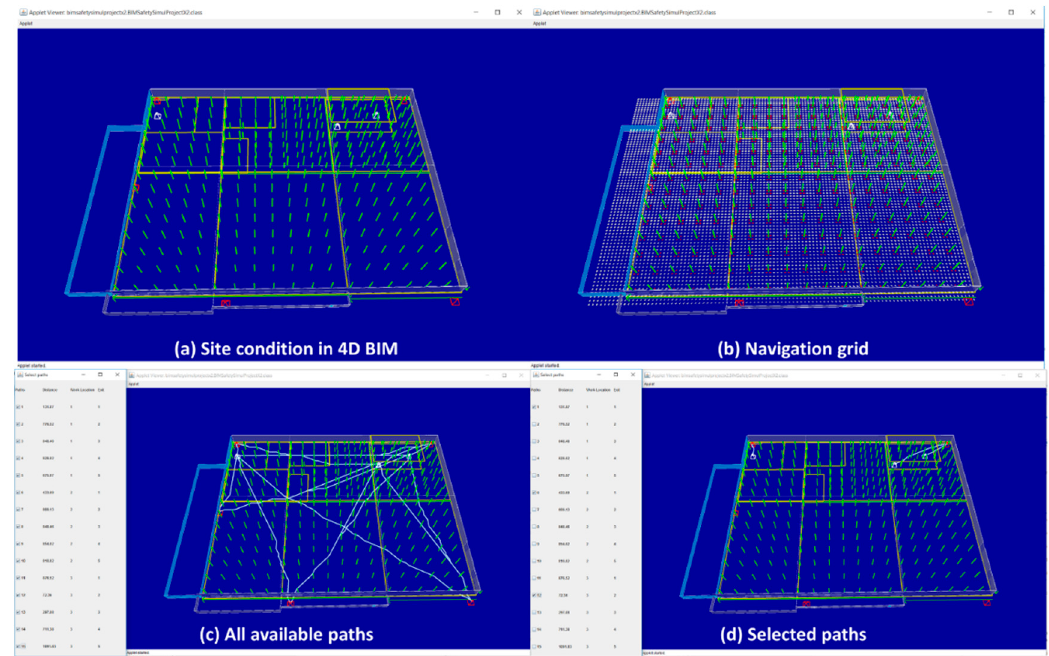
Figure 17. Scenario 3 ( a ) site condition, ( b ) navigation grid, ( c ) all available paths, and ( d ) selected paths.